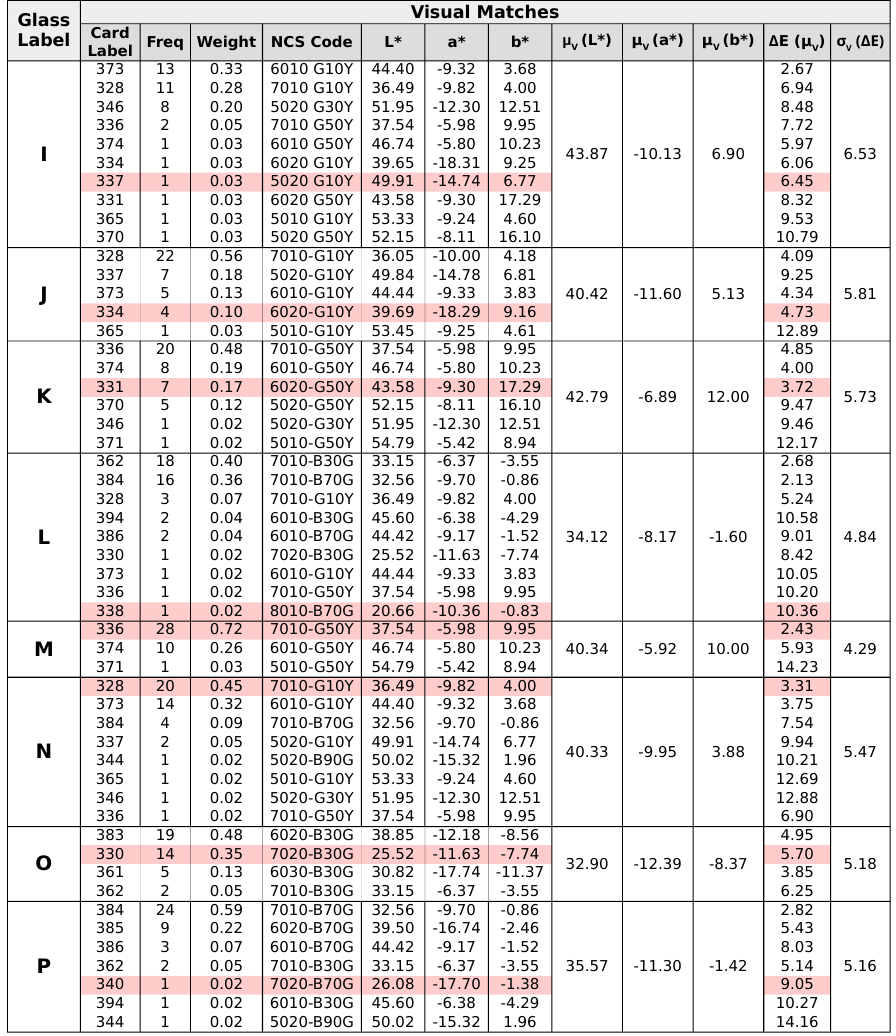
Table A5. Results from our visual matching experiment for the green-blue colour group. See Table A4 for an explanation of the data. Glass Label Card